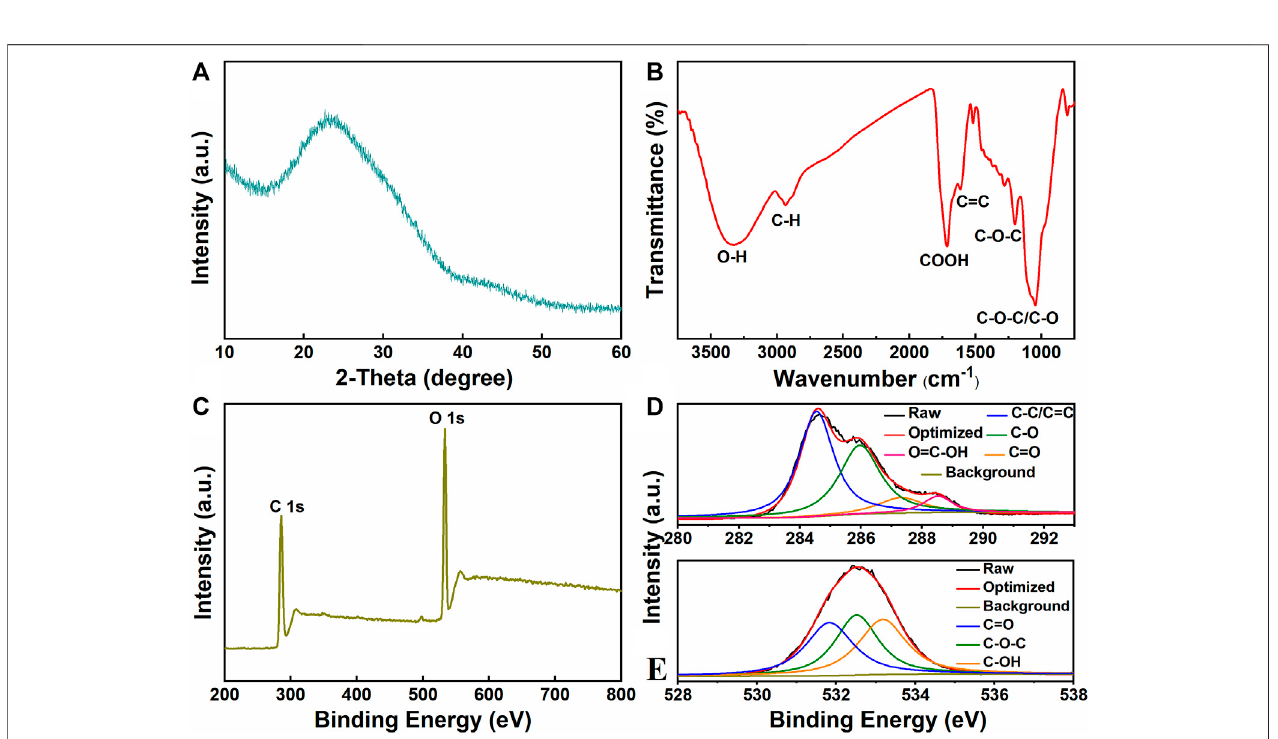
FIGURE 3 | (A) XRD patterns, (B) FT-IR spectra, (C) XPS spectra of CQDs, (D) C1s, and (E) O1s high-resolution spectra of the